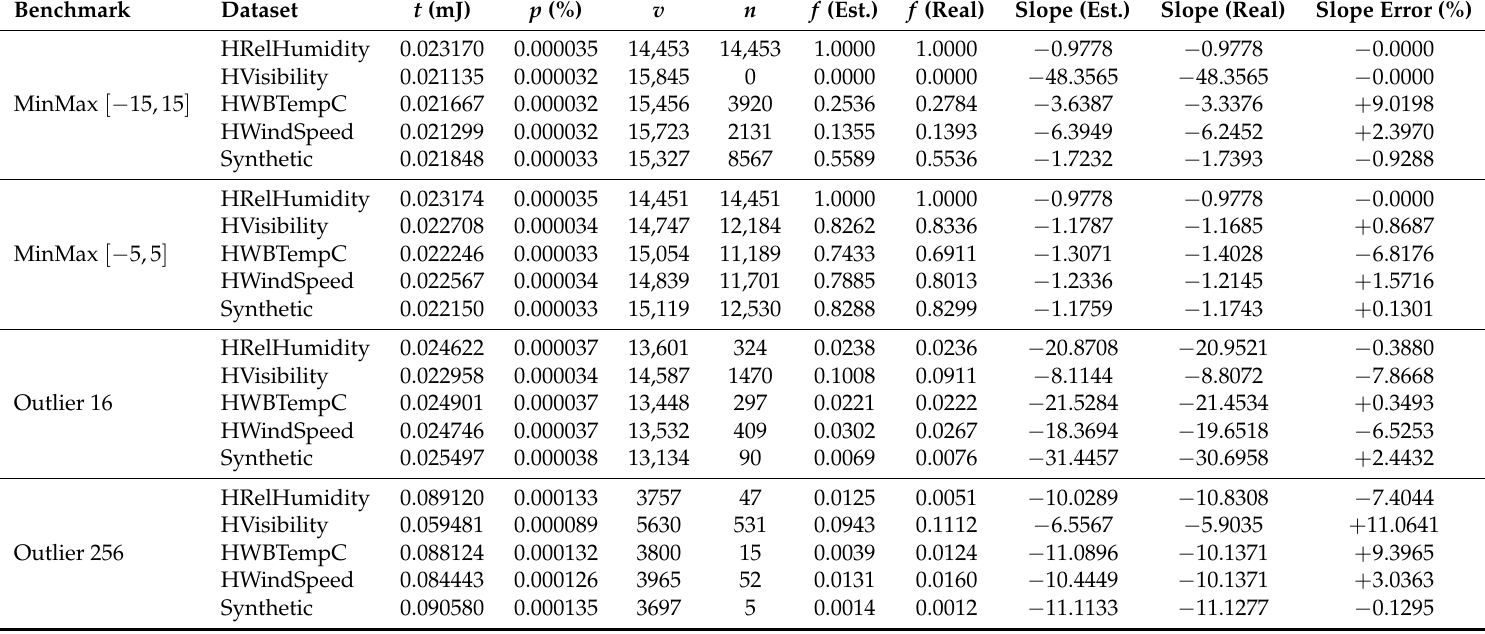
Table A4. NodeMCU energy consumption results in fog-prone